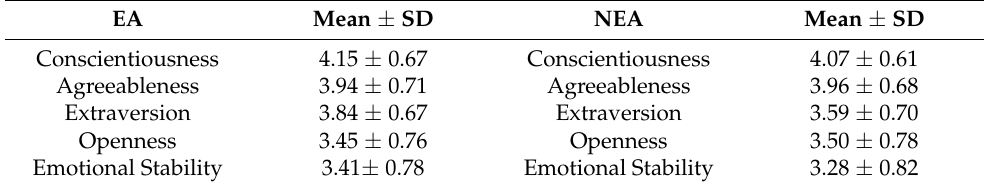
Table 1. Personality traits of table tennis players for elite and non-elite